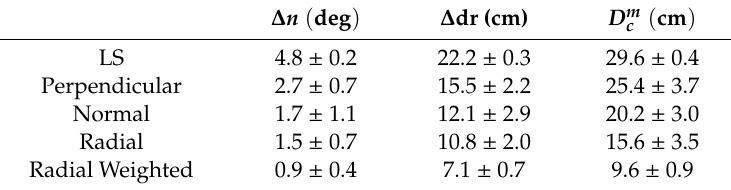
Figure 14. The errors of the control points after plane fitting calibration. Table 4. Mean values of the metrics for the third